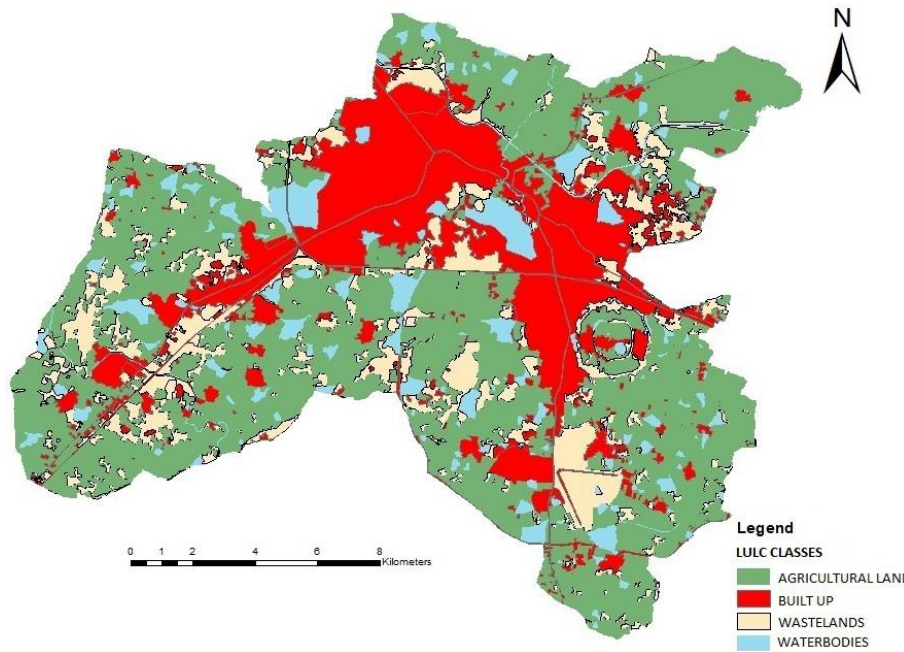
Fig. 6. LULC derived for the study